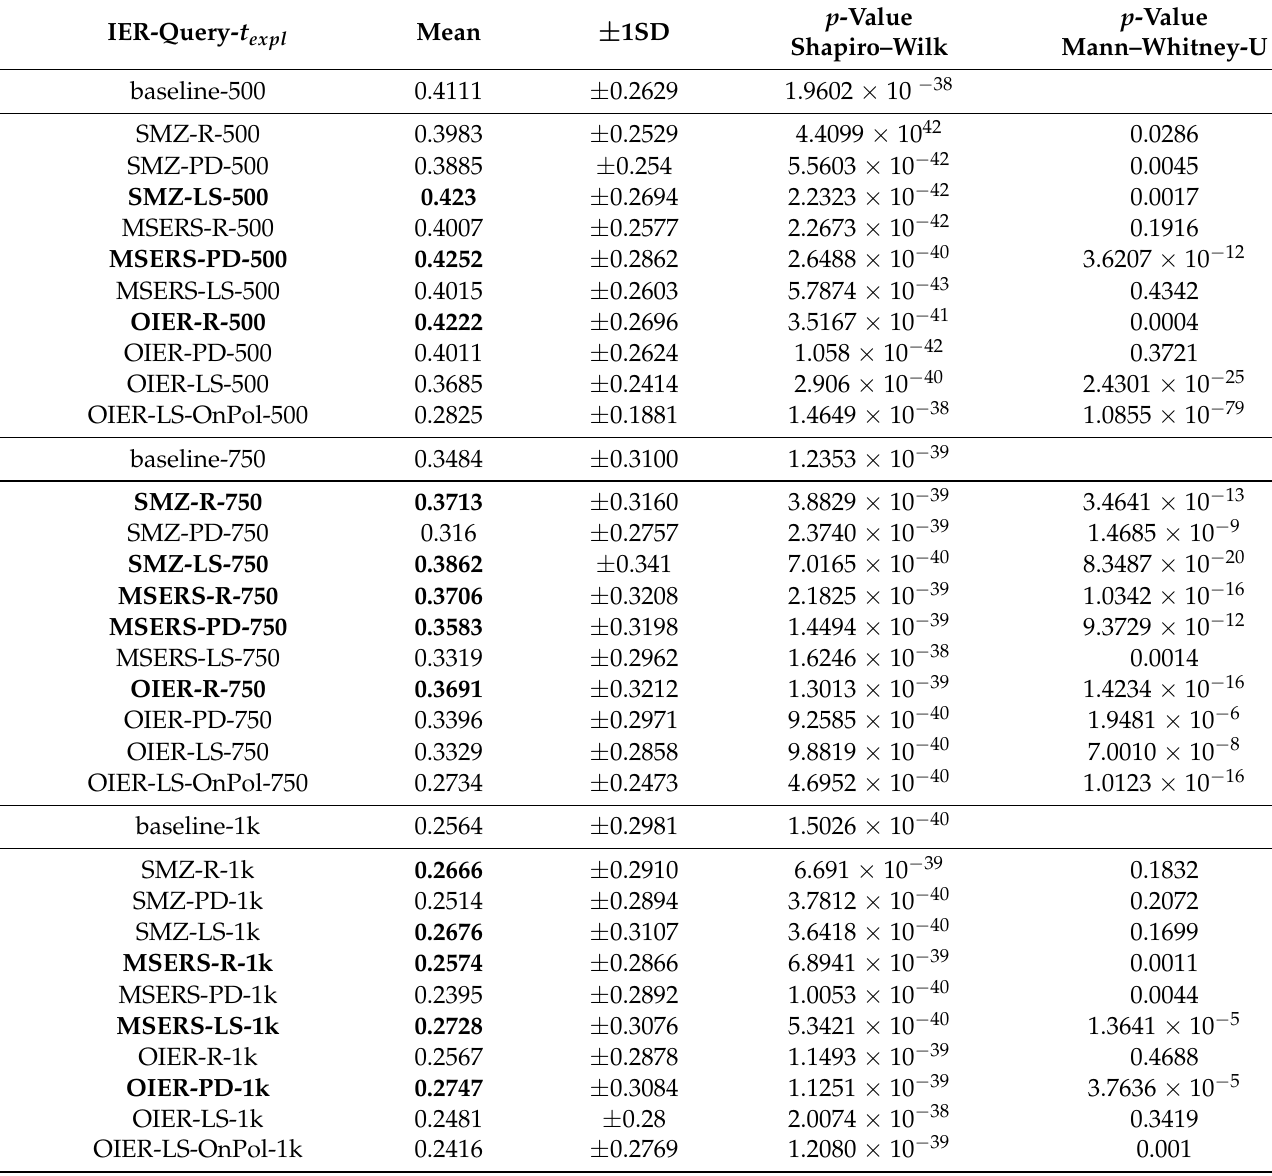
Table A1. A summary of the results of experiment 1 with state-encoding VE. Bold mean entries show a better performance in comparison to the corresponding baseline; bold IER-Query- t expl entries indicate statistically significant superior performance compared to the baseline.